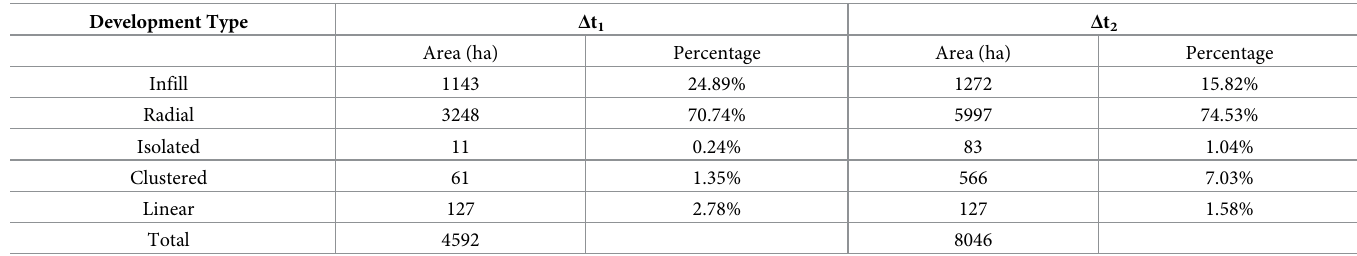
Table 3. New development in ha and percentage of total